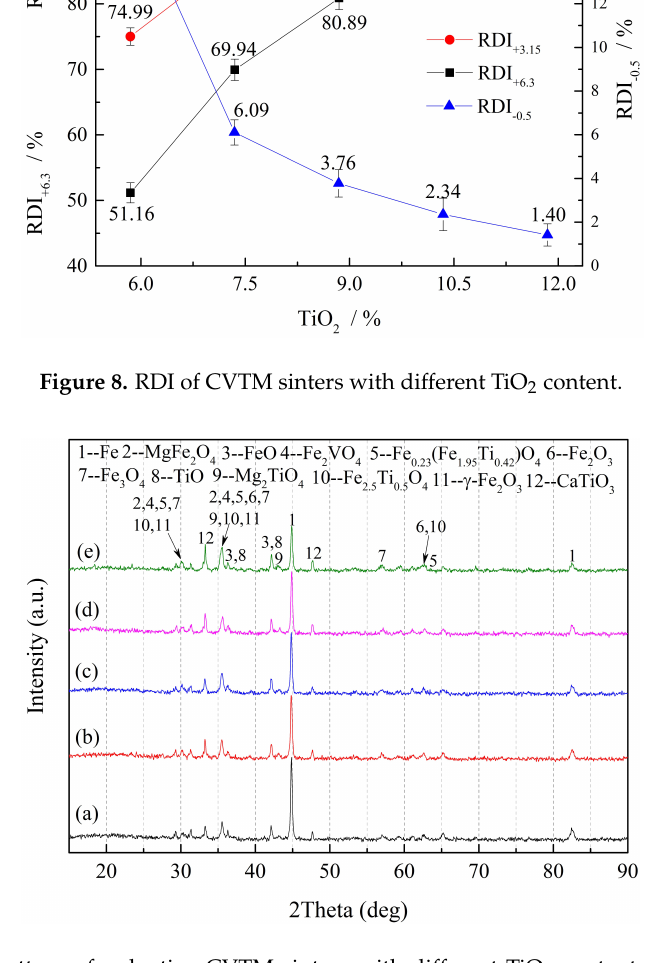
Figure 8. RDI of CVTM sinters with different TiO 2 content.